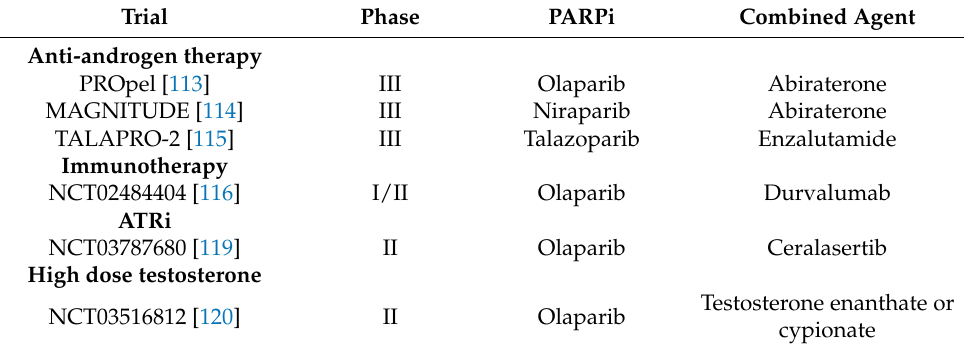
Table 5. Summary of clinical trials involving a PARPi in combination with an anti-cancer agent in BRCA -positive mCRPC